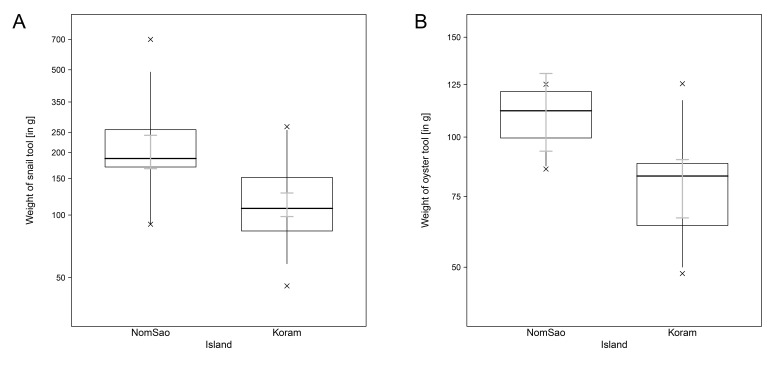
Tool weights of Koram and NomSao Islands.(A) Comparison between weights of stones used by macaques on Koram and NomSao Islands to open oysters. The plot shows all quantiles and the CIs (grey). (B) Comparison between weights of stones used by macaques on Koram and NomSao Islands to open snails. The plot shows all quantiles and the Cis (grey).10.7554/eLife.23647.004Figure 1—source data 1.Stone tools used.Shellfish foraging stone tools collected on Koram and NomSao Islands, Thailand.